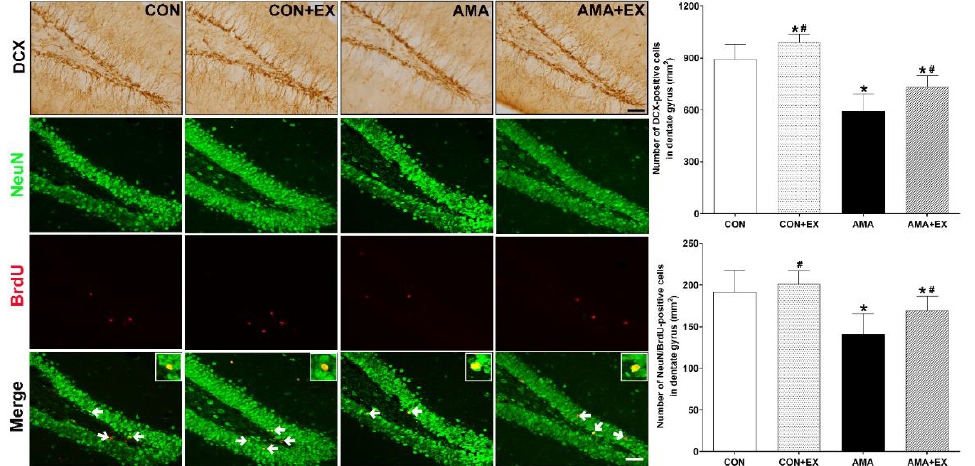
Figure 5. Effects of exercise on cell differentiation and neurogenesis in the hippocampal dentate gyrus of the offspring from mothers with advanced maternal age (AMA). Representative photomicrographs and data for DCX- and NeuN/BrdU-positive cells are shown. The scale bar represents 50 µ m. CON: offspring from the control group; CON + EX: offspring from the control and exercised group; AMA: offspring from the advanced maternal age group; AMA + EX: offspring from the advanced maternal age and exercised group; NeuN: neuronal nuclear protein; BrdU: 5-bromo-2 ’ -deoxyuridine. Data are expressed as means ± standard error of the mean (SEM). * p < 0 . 05 compared to the CON group. # p < 0 . 05 compared to the AMA group.